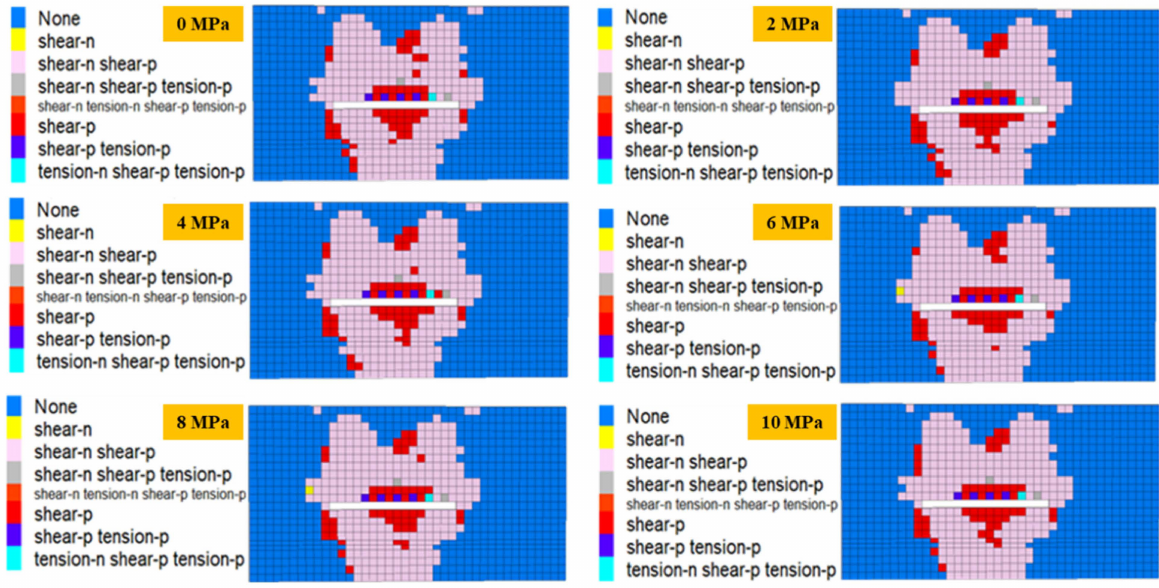
Figure 9. Plastic zone under different water